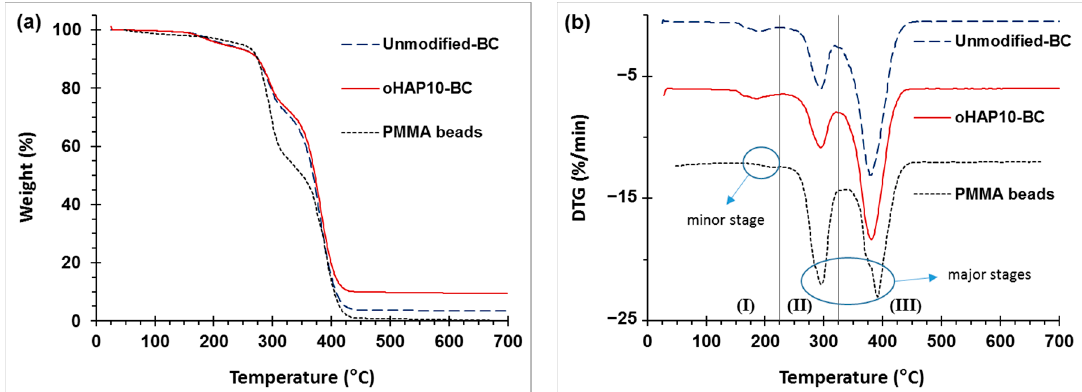
Figure 14. ( a ): TGA and ( b ): DTG curves of PMMA beads, unmodified BC and oHAP10-BC. Note: (unmodified-BC: 0 wt.% of HAP, with 5 wt.% of ZrO 2 ).